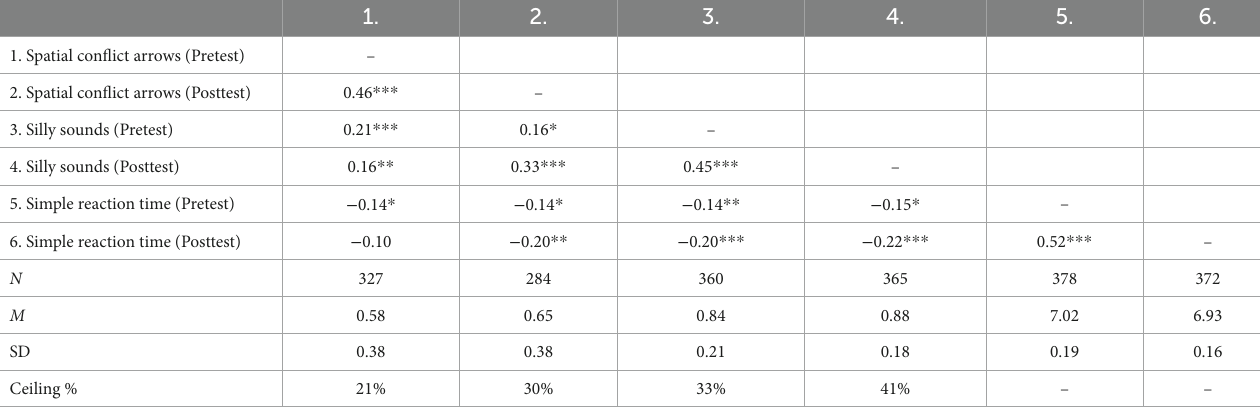
TABLE 1 Descriptive statistics and correlations among observed mean scores for inhibitory control